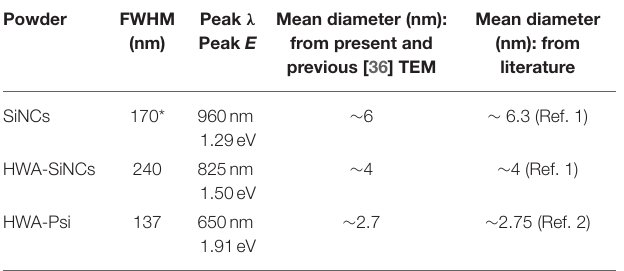
TABLE 1 | PL peak wavelength and energy and FWHM of indicated powders, from spectra shown in Figure 2 , and estimated mean size according to measurements and literature.